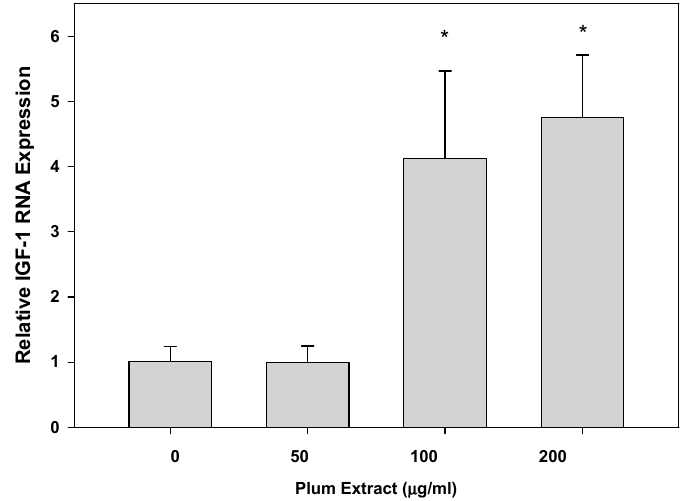
Figure 5. The e ff ect of plum extract of IGF-1 gene expression. Total RNA was extracted from C2C12 myotubules treated with various concentrations of plum extract and compared to untreated control. All results were obtained from at least three independent biological repeats. Data were analyzed using the ∆∆ CT method. Glyceraldehyde-3-phosphate dehydrogenase ( GAPDH ) genes were used as house-keeping genes for expression calculation. All comparisons were made to control (untreated cells) using one-way ANOVA; significant di ff erences are reported at * p <